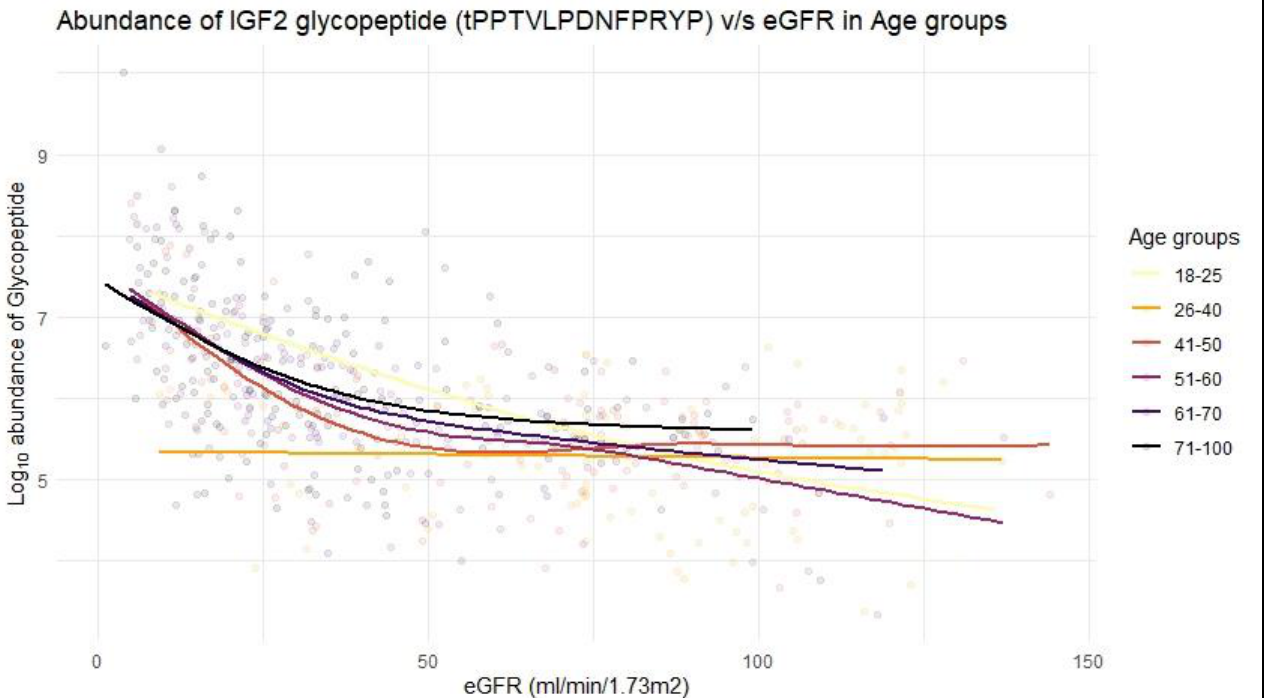
Table 2. Results of Spearman’s rank correlation test for the abundance of urinary IGF2 glycopep- tides with eGFR (mL/min/1.73 m 2 ) in different kidney disease etiologies. The significant correlations ( p < 0.05) are marked with an asterisk.